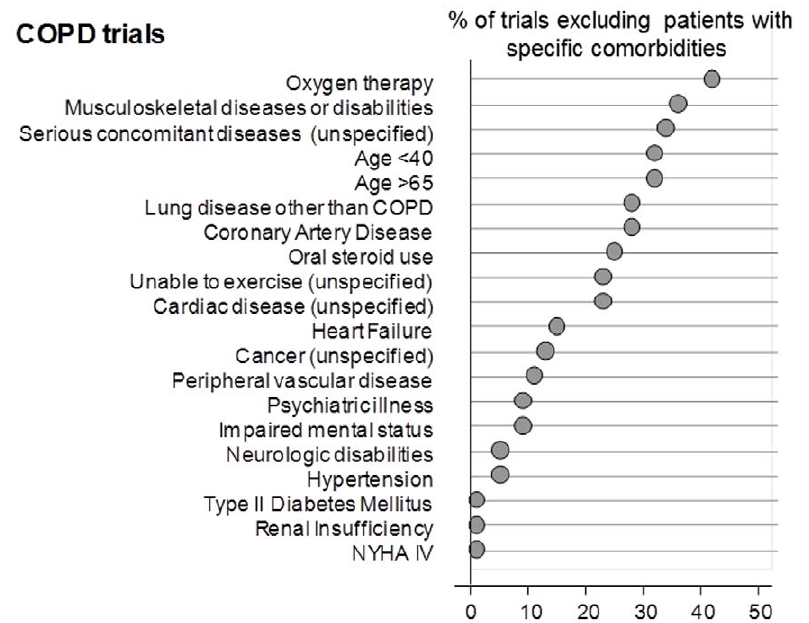
Figure 2. Proportion of chronic obstructive pulmonary disease ( COPD ) trials where patients with specific comorbidities were excluded.